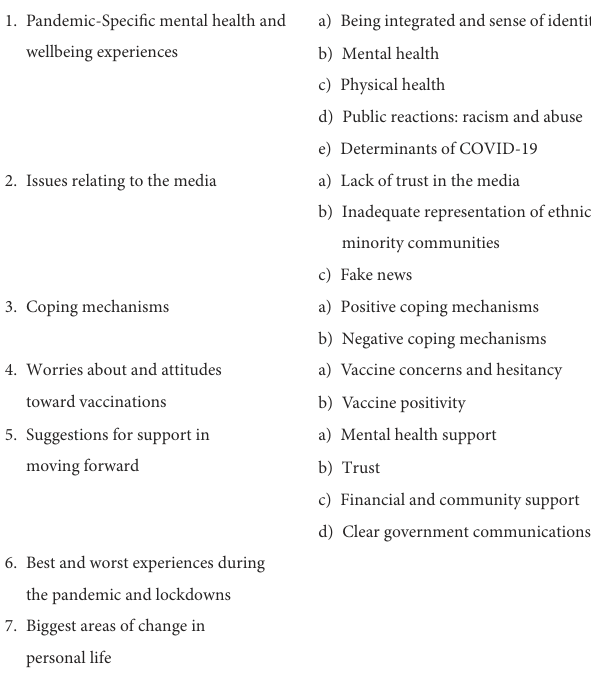
TABLE 5 Main themes and related